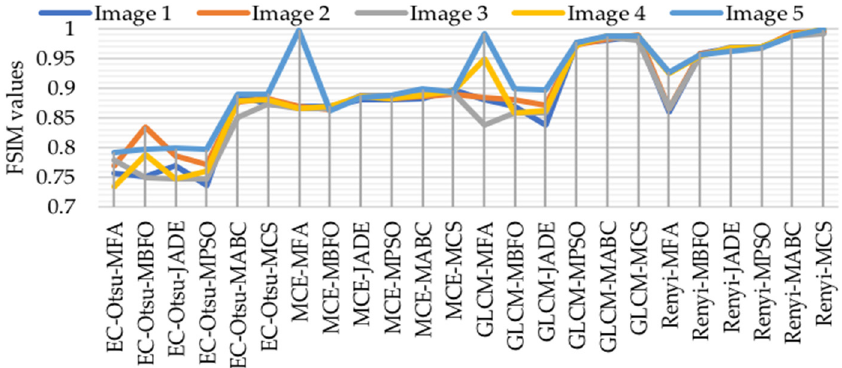
Figure 21. Results of FSIM values for all algorithms at level 8.